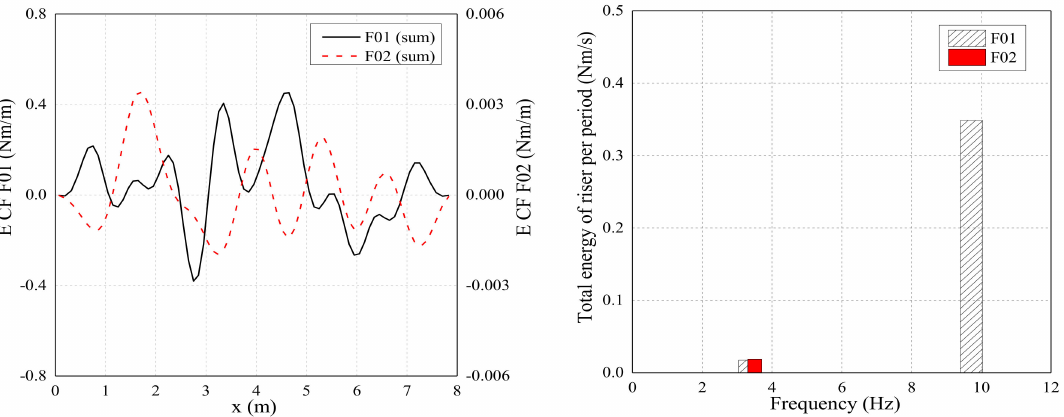
Figure 12. Distribution of vortex-shedding energy per unit period along pipe length and vibration frequency in CF direction of F01 and F02 under 1.6 m/s (E CF is the vortex-shedding energy per unit period).